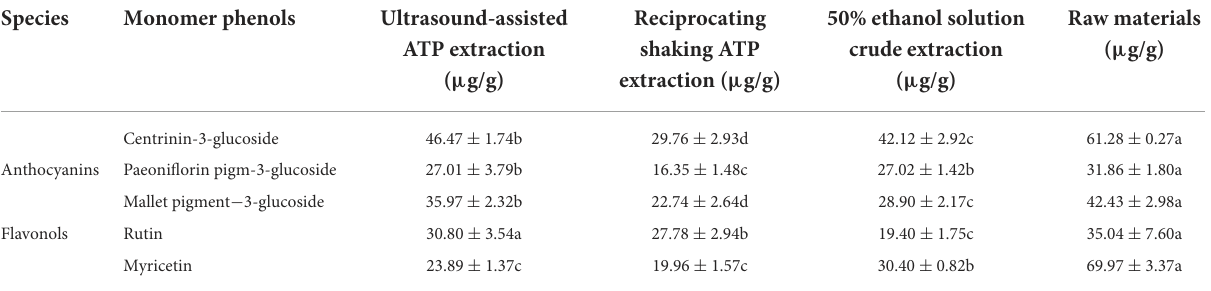
TABLE 2 Extraction yield of individual anthocyanins and flavonols.